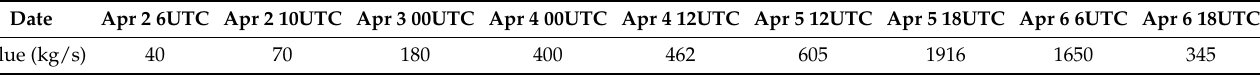
Table 1. Adjusted SO 2 emission in kgs − 1 between April 2nd and 7th 2007 for forcing at the vent.